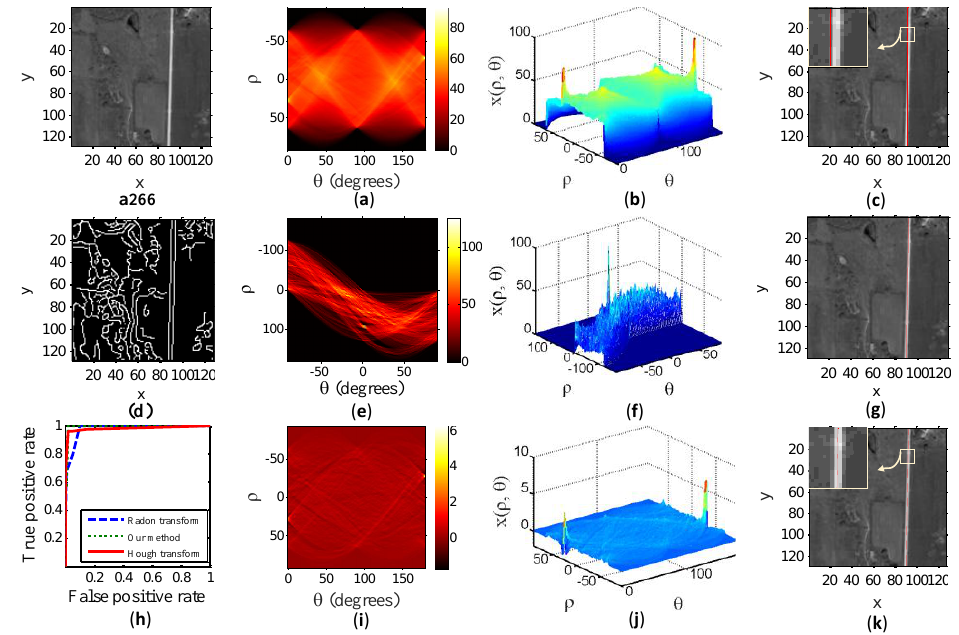
Figure 5. a266 is a test image. ( a ) Radon transform of test image in two-dimensional parameter space. ( b ) Three-dimensional form of ( a ). ( c ) Detected line from ( b ) overlaid on test image. ( d ) Binary image of the test image. ( e ) Hough transform of ( d ). ( f ) Three-dimensional form of ( e ). ( g ) Detected line from ( f ). ( h ) Receiver Operator Curves of the evaluated detection methods. ( i ) Transform image obtained by our method. ( j ) Three-dimensional form of ( i ). ( k ) Detected line from ( j ).